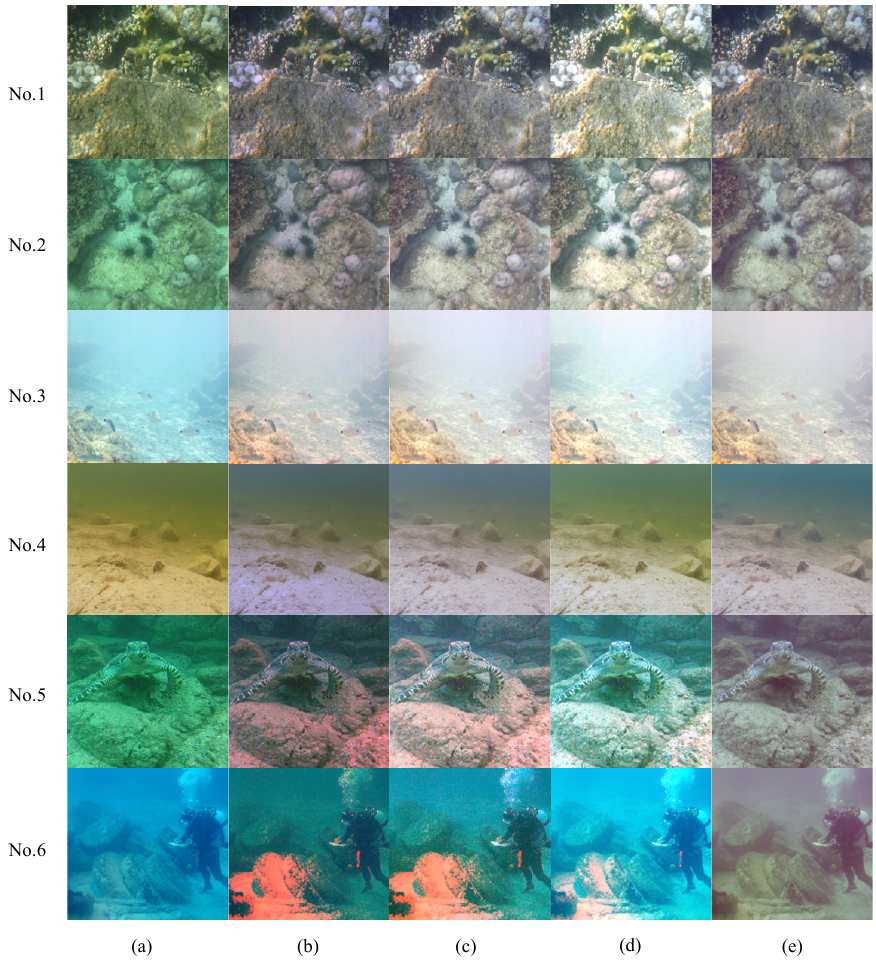
Figure 4. Visual comparison of color balance results of underwater images. ( a ) Real underwater images; ( b ) processed by gray world algorithm [31]; ( c ) processed by color shift check correction [32]; ( d ) processed by automatic white balance [33]; and ( e ) processed by proposed